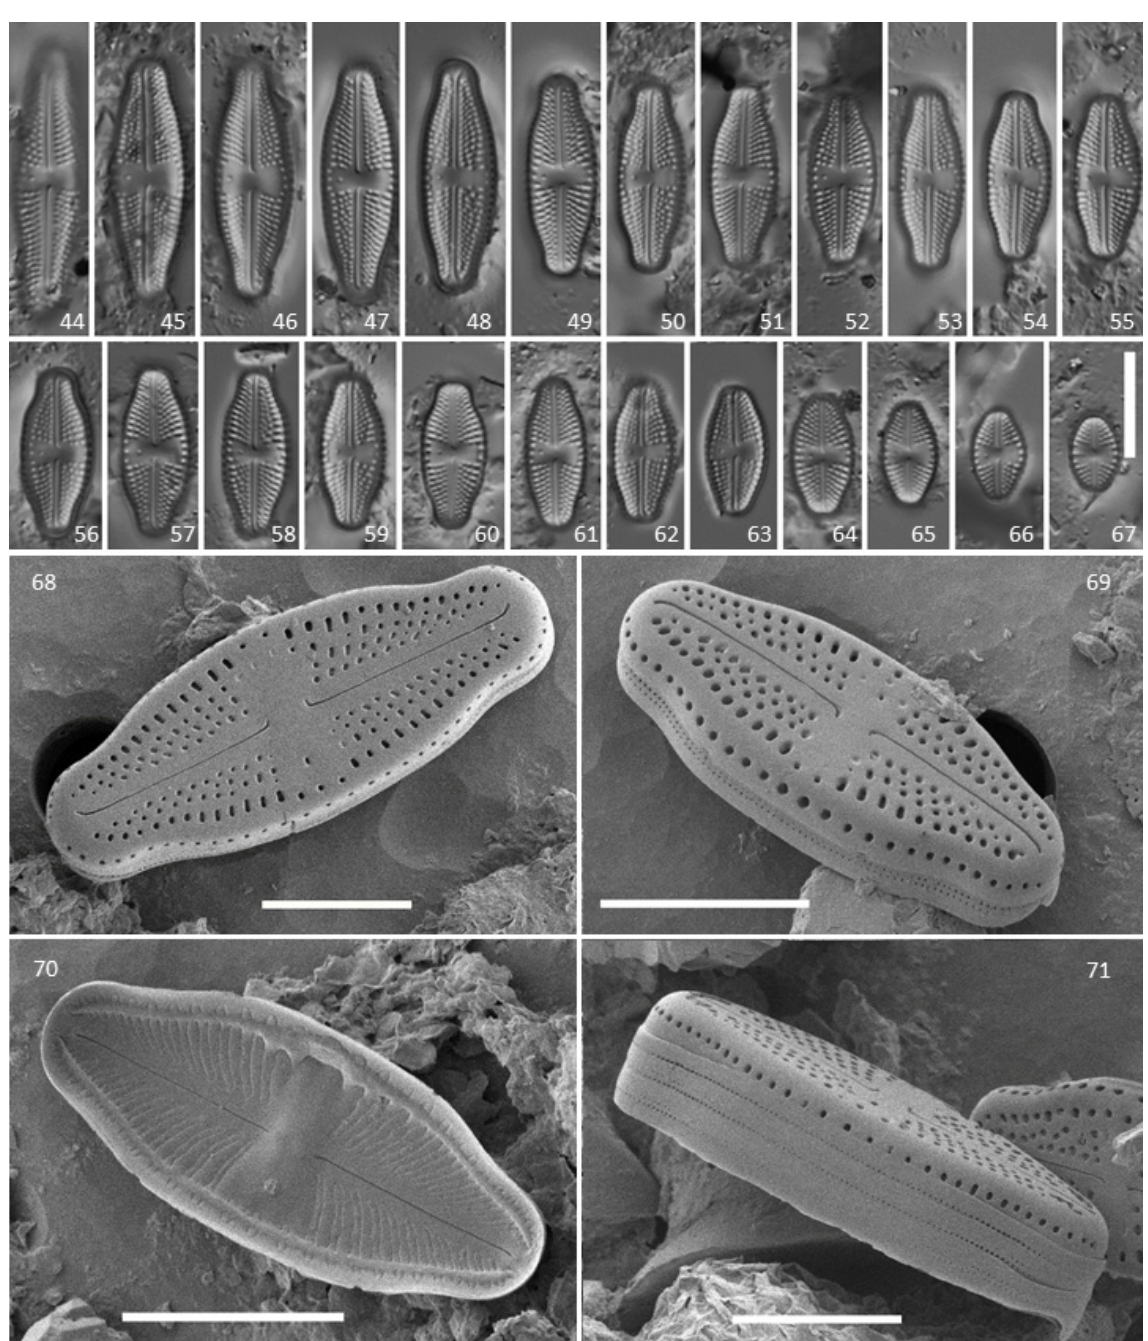
Figs 44–71. Luticola vancampiana Chattová & Van de Vijver sp. nov. Light (LM) and scanning electron micrographs (SEM) from the type population from Conserverie on Ile Saint-Paul, B. Van de Vijver sample S029 . 44–67 . LM showing the variation in size and shape of the valve apices. 68–69 . SEM of valve exterior. 70 . SEM of valve interior. 71 . SEM girdle view. Scale bars: 44–67 10 µm; 68–71 = 5